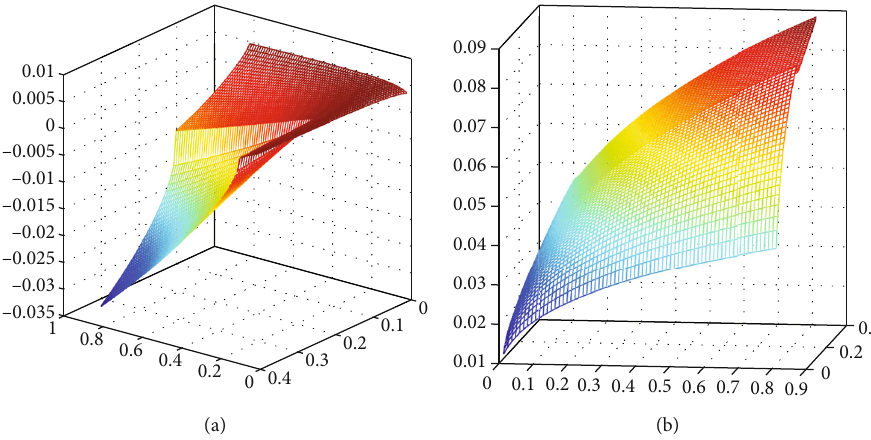
ϑ 1 and 2 are represented in (a) and (b), respectively.